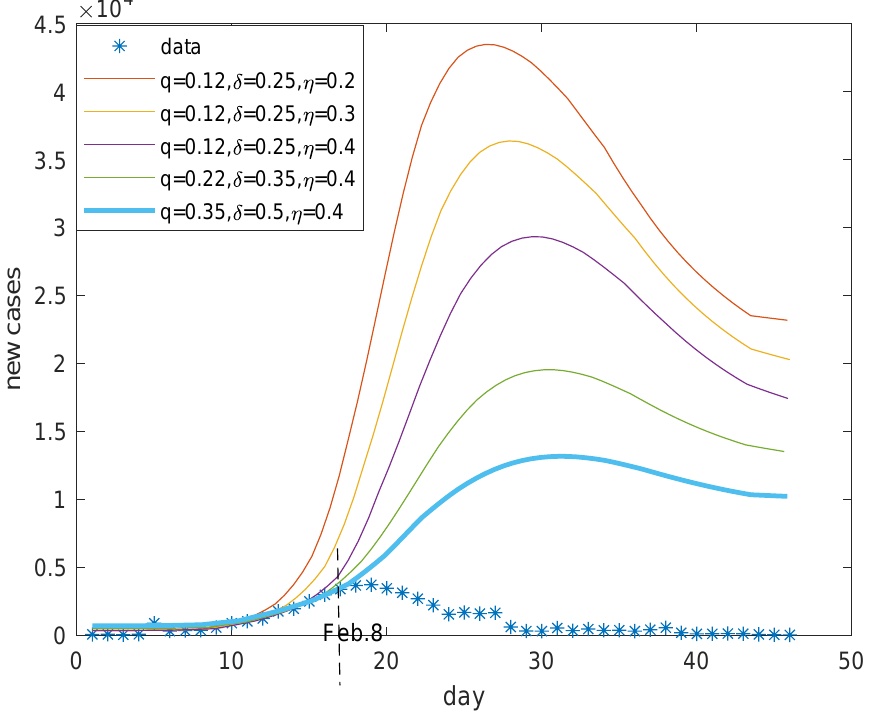
Figure 9. Effect of control measures in Wuhan. The increased contact tracking rate q , the strengthened Fig. 9: Effect of control measures in Wuhan incidence decline rate η , and the improved admission rate δ obviously reduce infections and enable people to control COVID-19 in